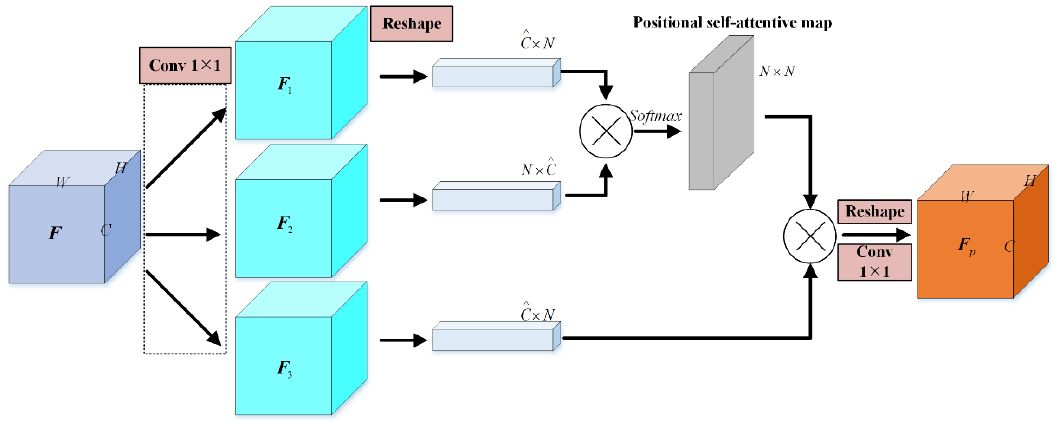
Figure 1. Illustration of non-local block.